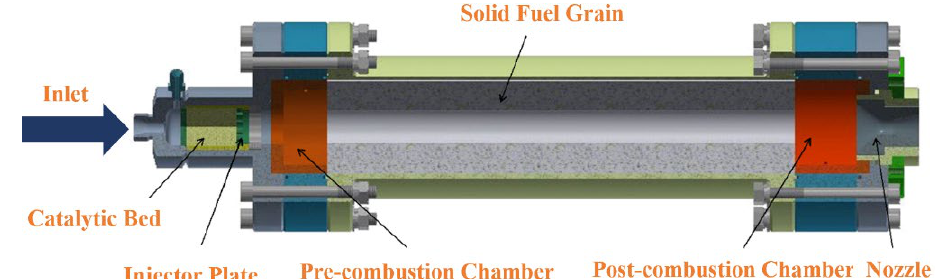
Figure 6. Schematic of experimental HRM [4].